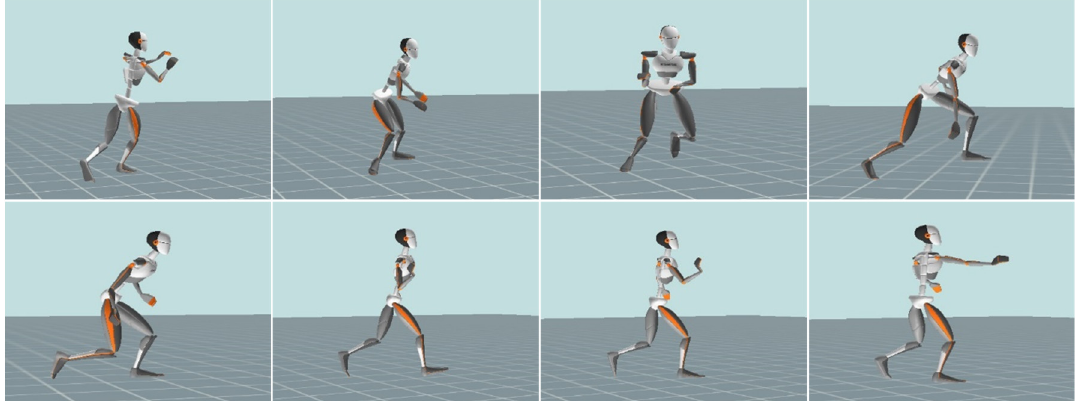
Figure 4. Kinogram from the point of catching the ball until releasing it from the wrist.